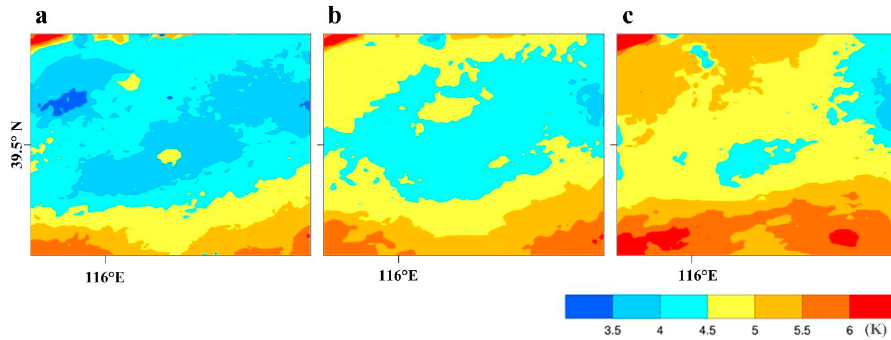
Figure 4. The temperature (K) difference between day and night under different land surfaces at 2 m. ( a ), ( b ), and ( c ) are NU, CU, and FU, respectively.